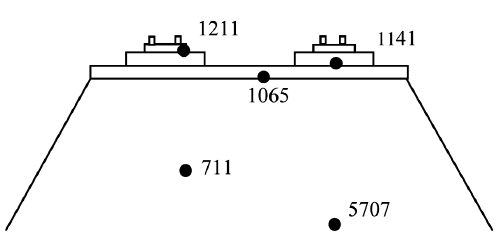
Fig. 2. Typical geometry for railway track